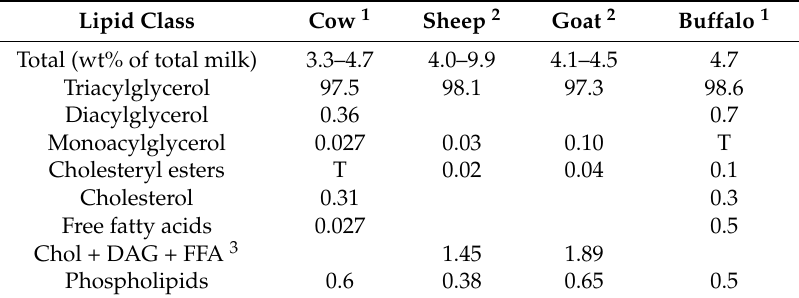
Table 1. Fat content of milk from various species (wt% of the total